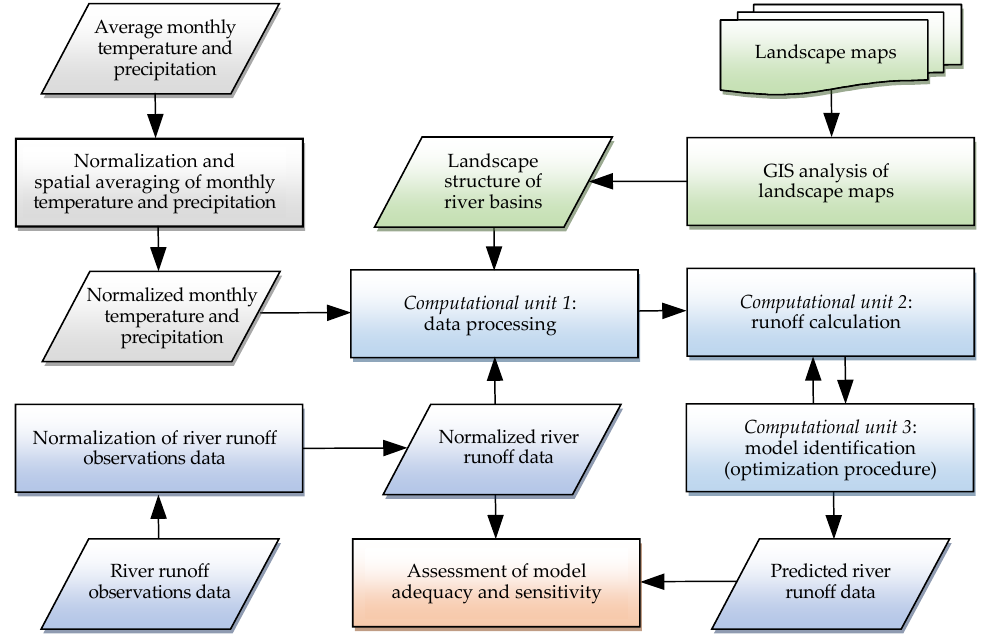
Figure 3. Flow chart of SAM methodology for building the process-driven hydrological